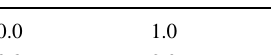
Weight of date pit powder